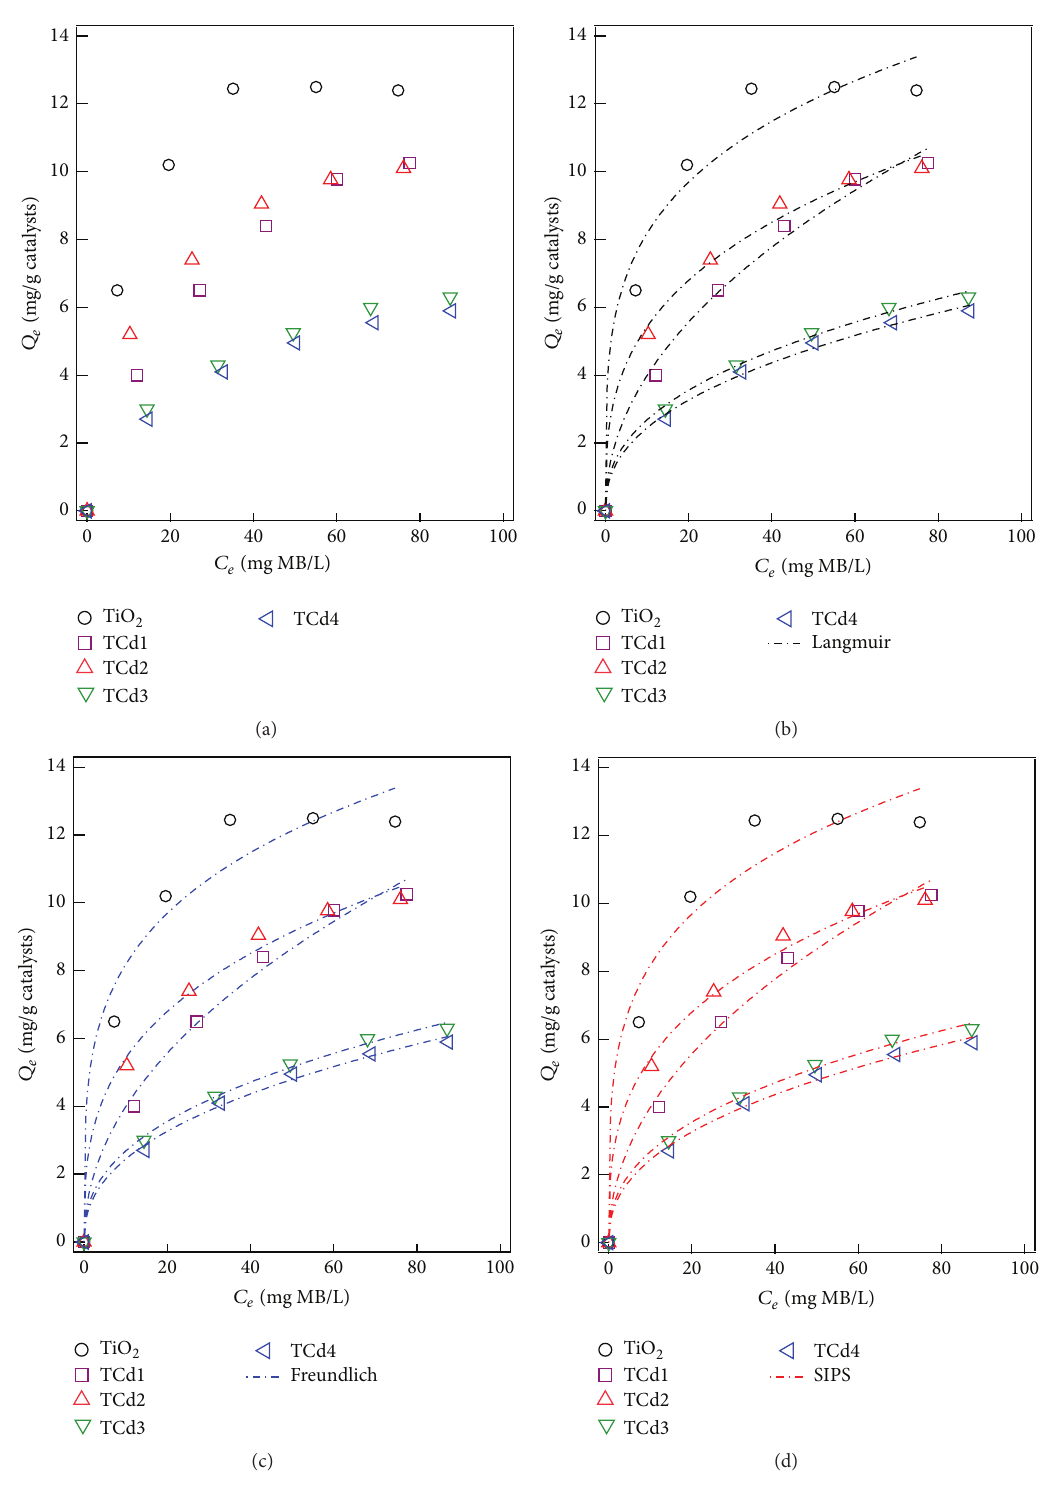
Figure 7: (a) Profile of MB sorbed as a function of equilibrium concentration for the different adsorbents. Other panels show nonlinear fit of experimental data from (a) to (b) Langmuir, (c) Freundlich, and (d) Freundlich-Langmuir model equations. Experimental conditions: pH = 7.44 and 𝑇 = (300.0 + 0.3) K and initial MB adsorbate concentration, 𝐶 0 = 100.0 mg L −1